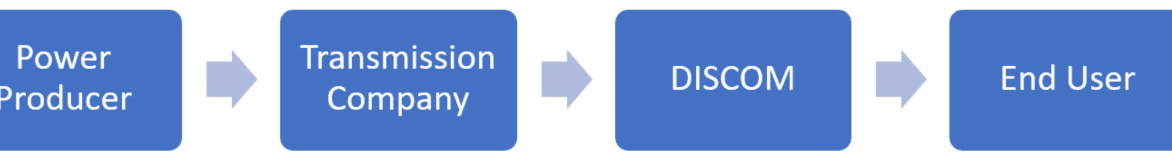
Figure 1. Flow of